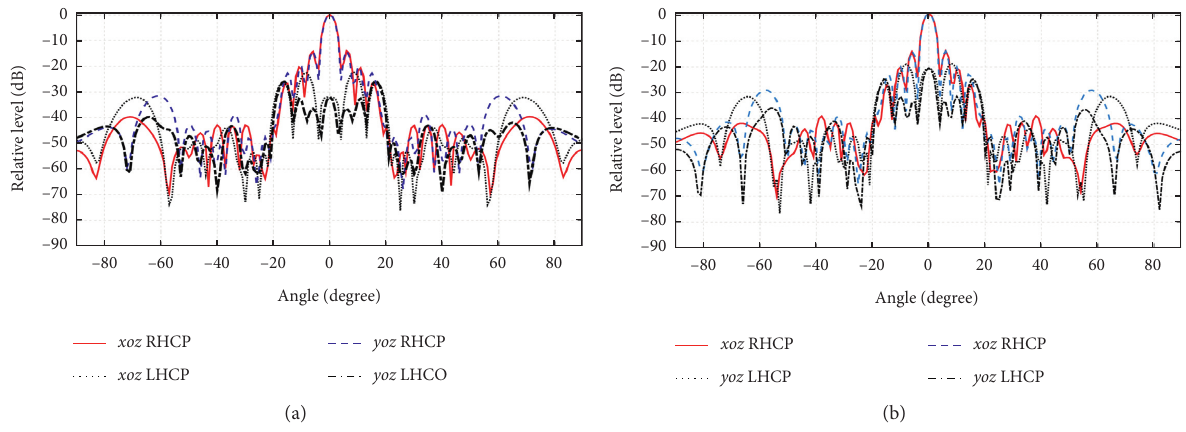
Figure 18: Simulated normalized radiation patterns of the antenna array at (a) 28GHz and (b) 29GHz. Table 2: Comparison between proposed and reported millimeter-wave CP array